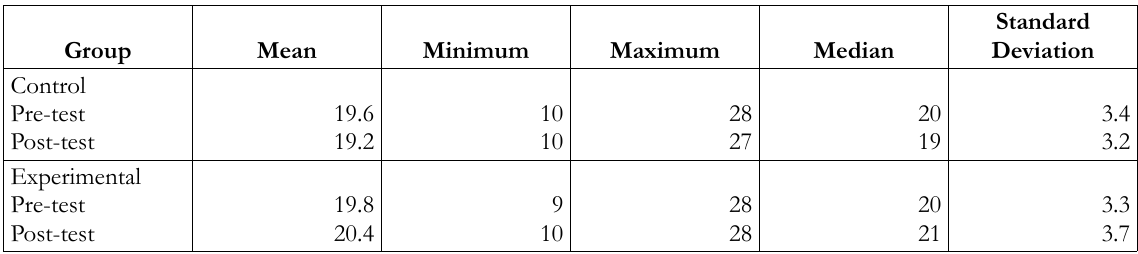
Table 3. Descriptive Data of Students’